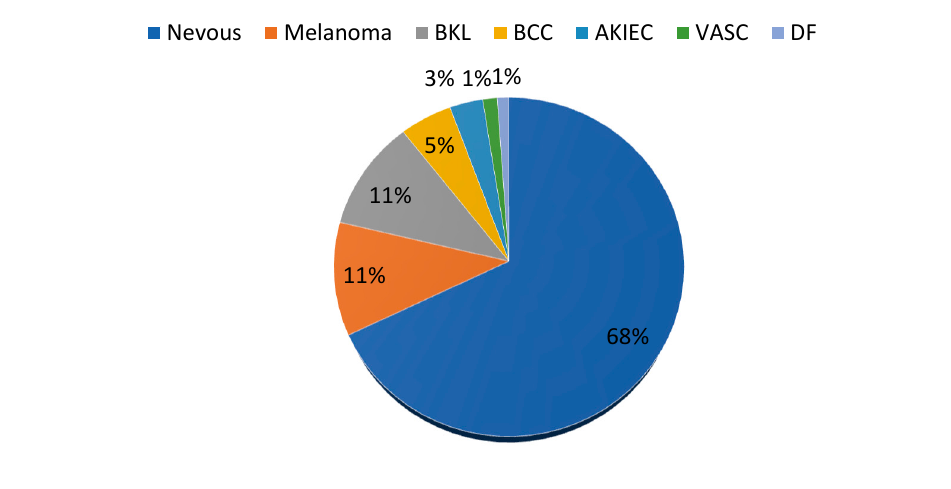
Figure 2. The HAM-10000 dataset divided into seven categories by percentage.